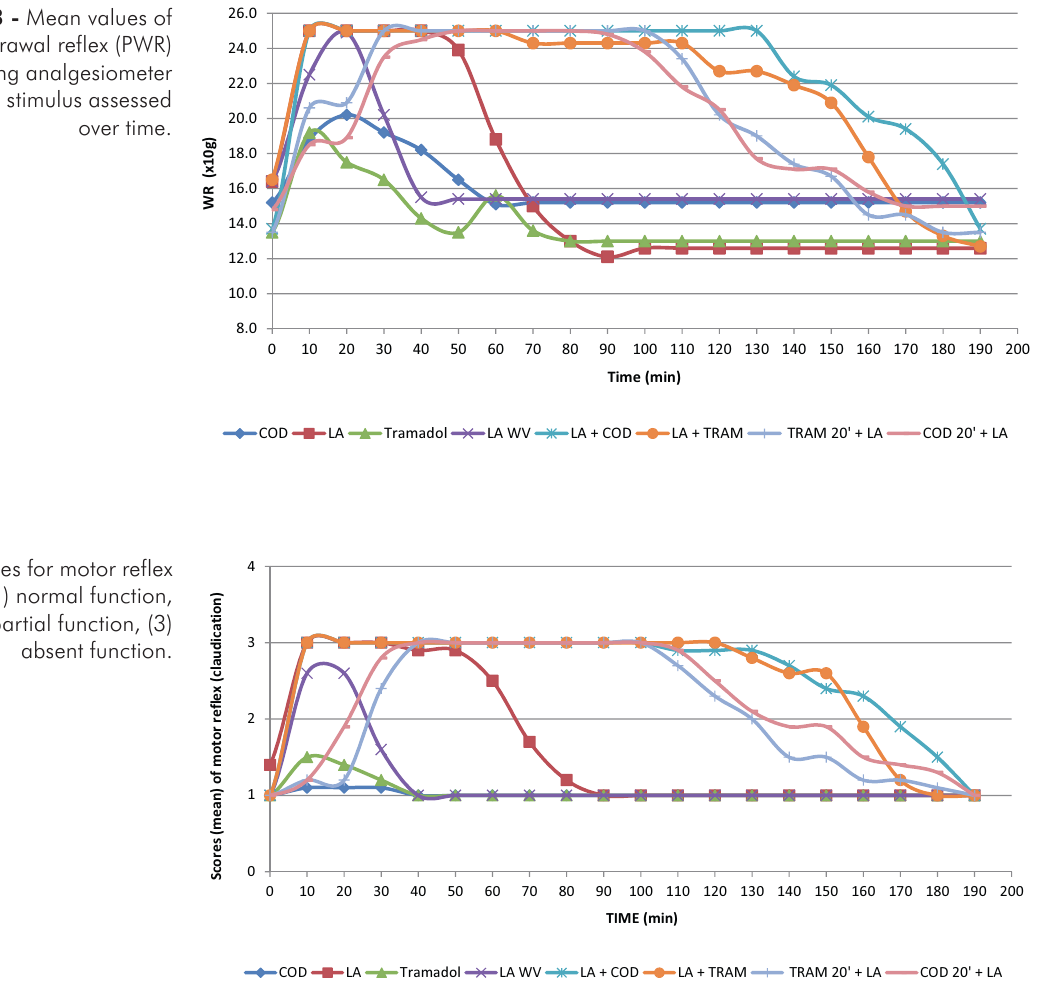
Figure 3 - Mean values of